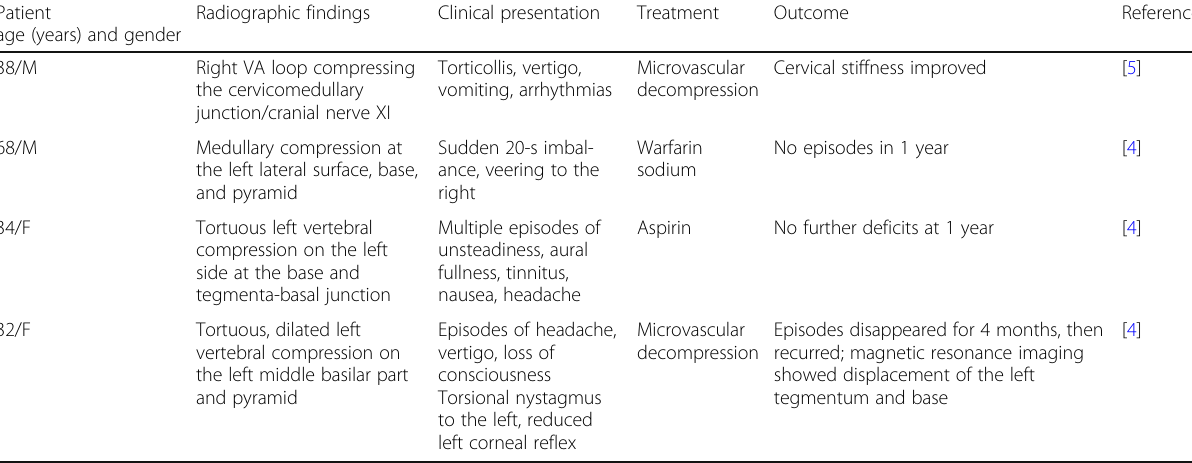
Table 1 Reported cases of vertebral artery compression of the medulla associated with vertigo and/or imbalance Patient Radiographic age (years) and gender